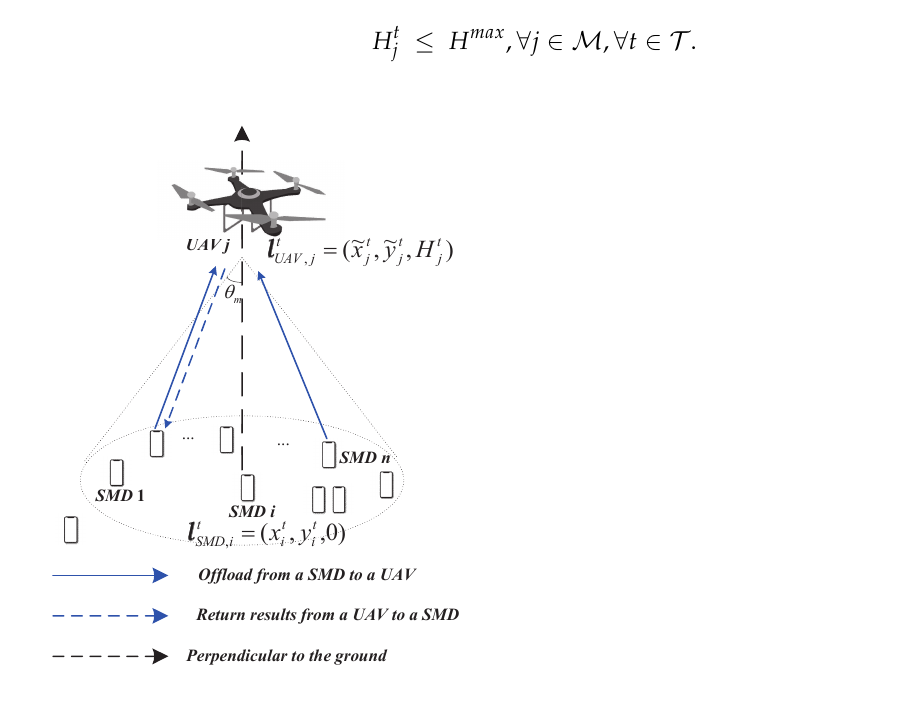
Figure 2. The service range of unmanned aerial vehicle (UAV) j